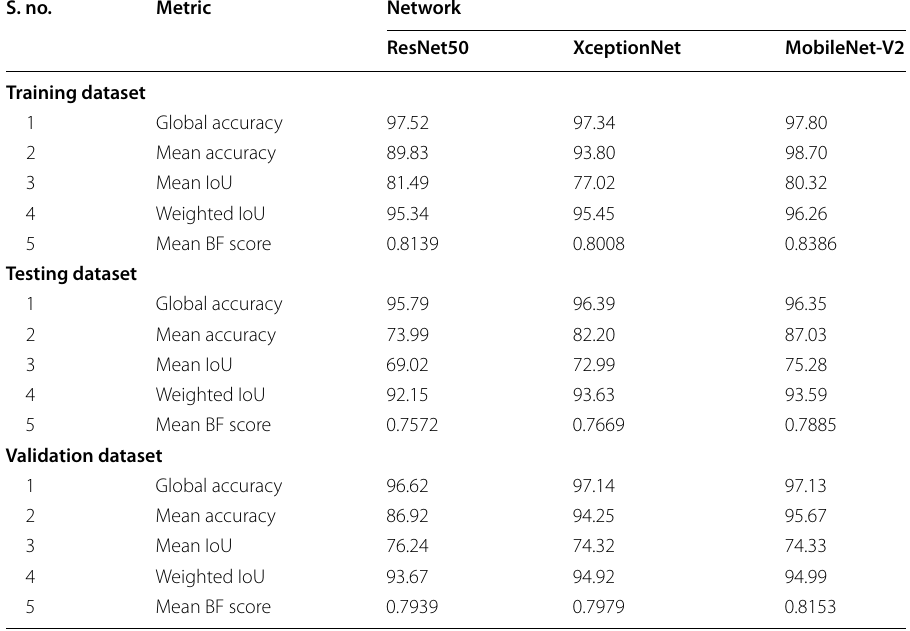
Table 3 Compared dataset performance metrics for each network S.